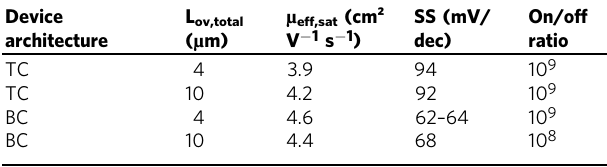
Table 2 Summary of the static performance of top-contact and bottom-contact DPh-DNTT TFTs shown in Fig. 6, having a channel length of 8 µ m and a channel width of 200 µ